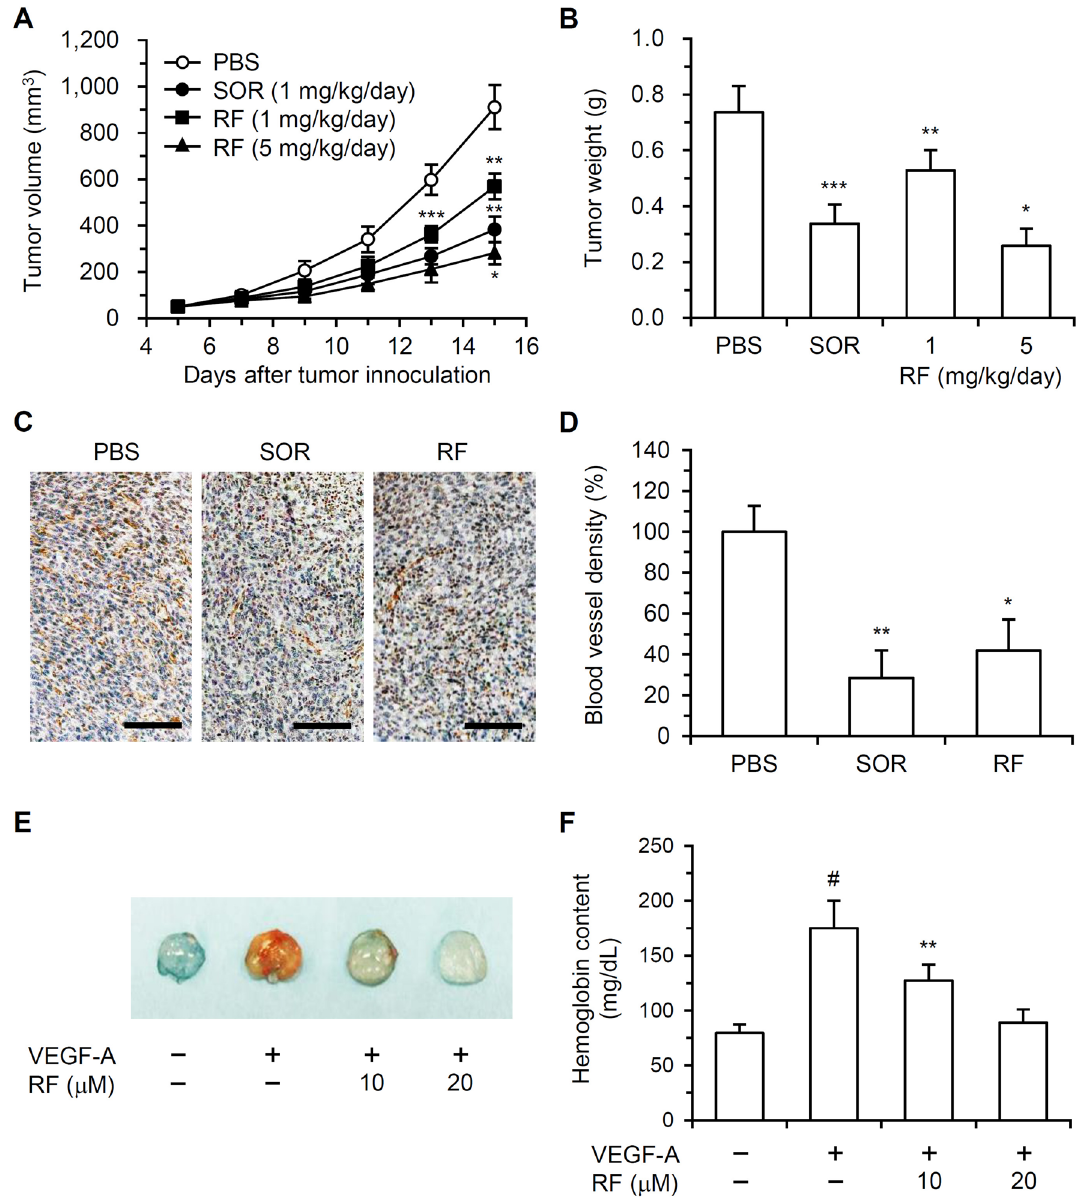
Figure 6. Effect of RF on tumor growth and tumor-induced angiogenesis in an animal CT-26 allograft colon carcinoma model and capillary vessel formation in an in vivo Matrigel plug. ( A ) CT-26 cells (5 × 10 5 in 200 μL PBS) were subcutaneously injected into the right flank of BALB/c mice. After the establishment of tumors (5 days; ~ 50 mm 3 ), the mice were injected peritumorally with RF (1 or 5 mg/kg/day in PBS with 0.2% DMSO), SOR (1 mg/kg/day in PBS with 0.2% DMSO), or PBS with 0.2% DMSO. The tumor volumes are presented as the mean ± SE; * p < 0.05, ** p < 0.01, *** p < 0.001, compared to the PBS-treated control group. ( B ) Tumor weight after necropsy is presented as the mean ± SE; * p < 0.05, ** p < 0.01, *** p < 0.001, compared to the PBS-treated control group. ( C ) Blood vessel density in tumor sections was determined using immunohistochemical analysis of CD31. All tumor sections were digitized, and microscopy images were captured at 100 × magnification (scale bar, 100 µm). ( D ) The density of immunohistochemical staining for CD31 was analyzed using ImageJ and is presented in the bar graph. The intensity of immunohistochemical staining for CD31 in the PBS-treated control group was set to 100%. The data are presented as the mean ± SD; * p < 0.05, ** p < 0.01, compared to the PBS- treated control. ( E ) Matrigel containing VEGF-A (500 ng/mL) and/or RF (10, 20 μM) was injected bilaterally into the flank areas of BALB/c mice. At seven days post-injection, the Matrigel plugs were excised and imaged. ( F ) The hemoglobin content in the Matrigel plugs was determined by a colorimetric hemoglobin assay. The data are presented as the mean ± SD of three independent experiments; # p < 0.05, compared to the control group not treated with VEGF-A or RF; ** p < 0.01, compared to the VEGF-A-treated